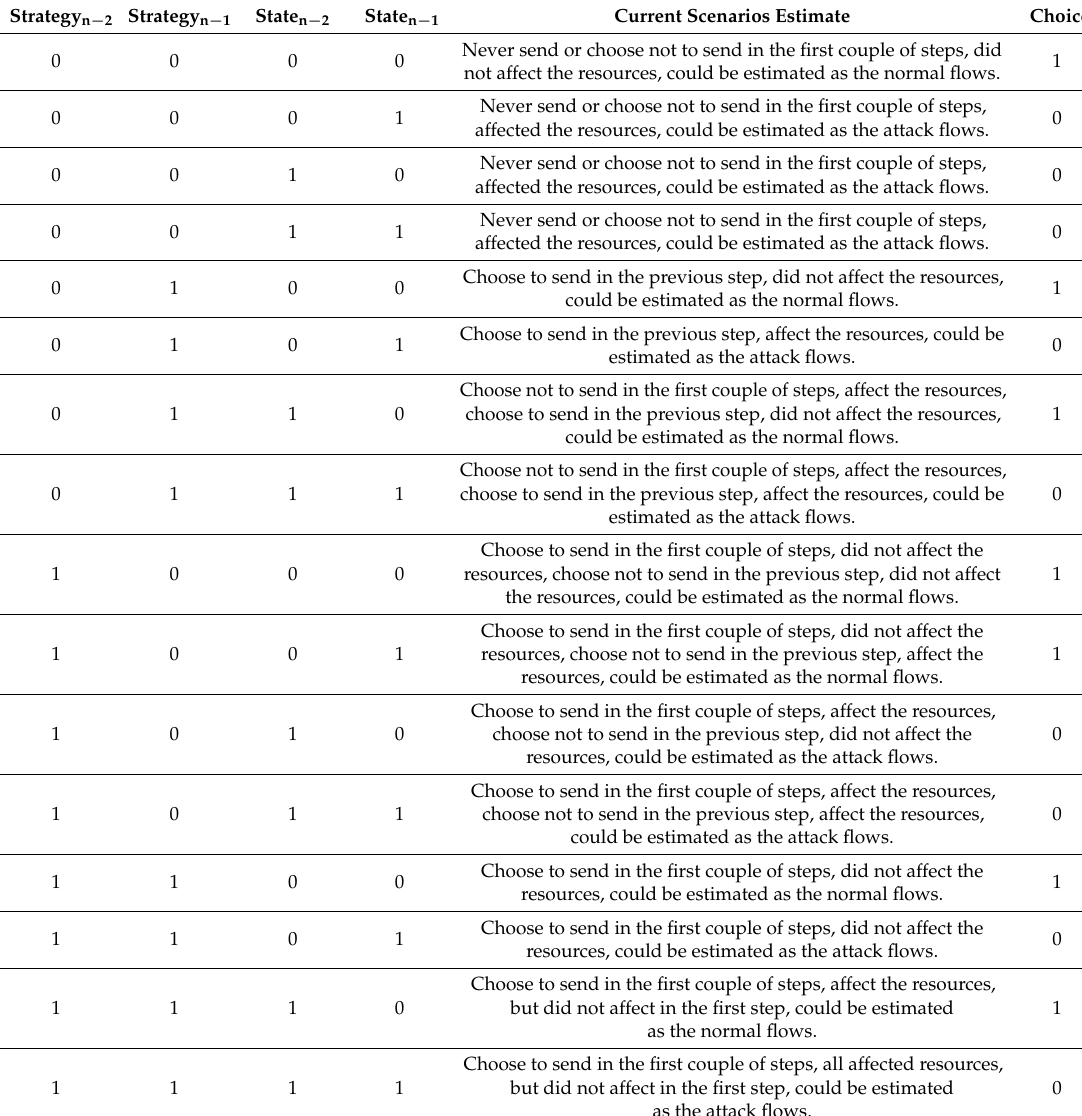
Table 1. Incomplete strategies and history